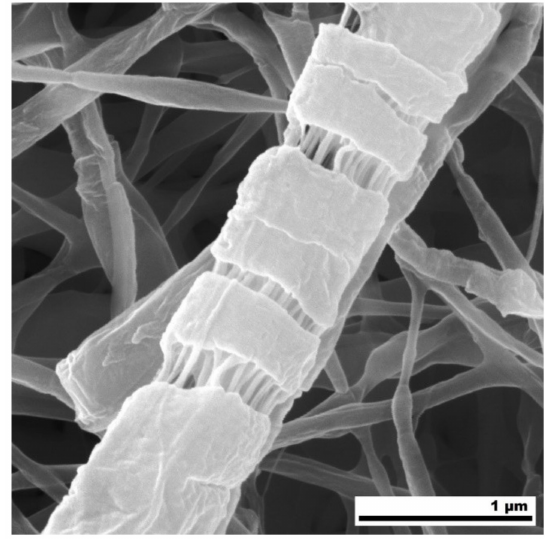
Figure 7. SEM micrograph of PCL15 / PEO85 nanofibrous mats after the tensile test leading to the material fracture. It revealed an internal structure of nanofibers consisting of PCL-based fibrils (supposed to be PCL / PEO blend) in the fragile PEO